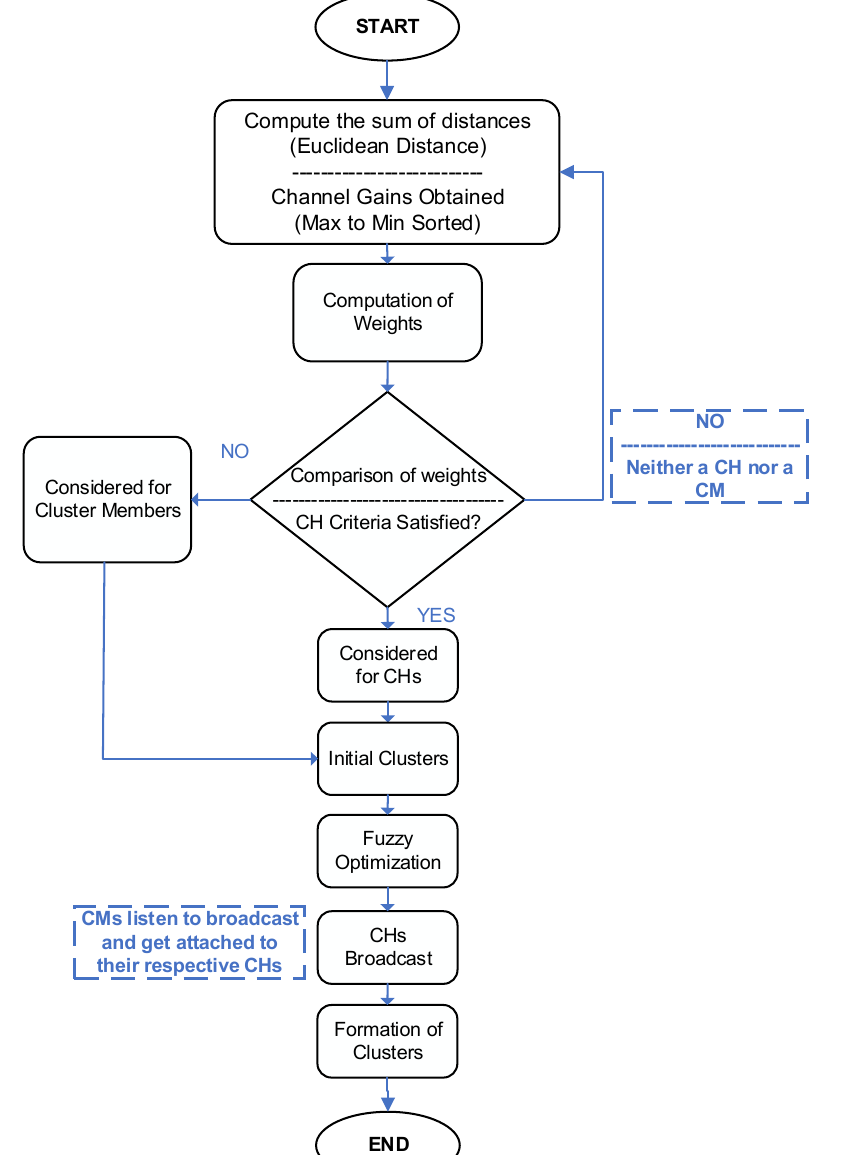
Figure 5. Flow chart of the proposed clustering algorithm.